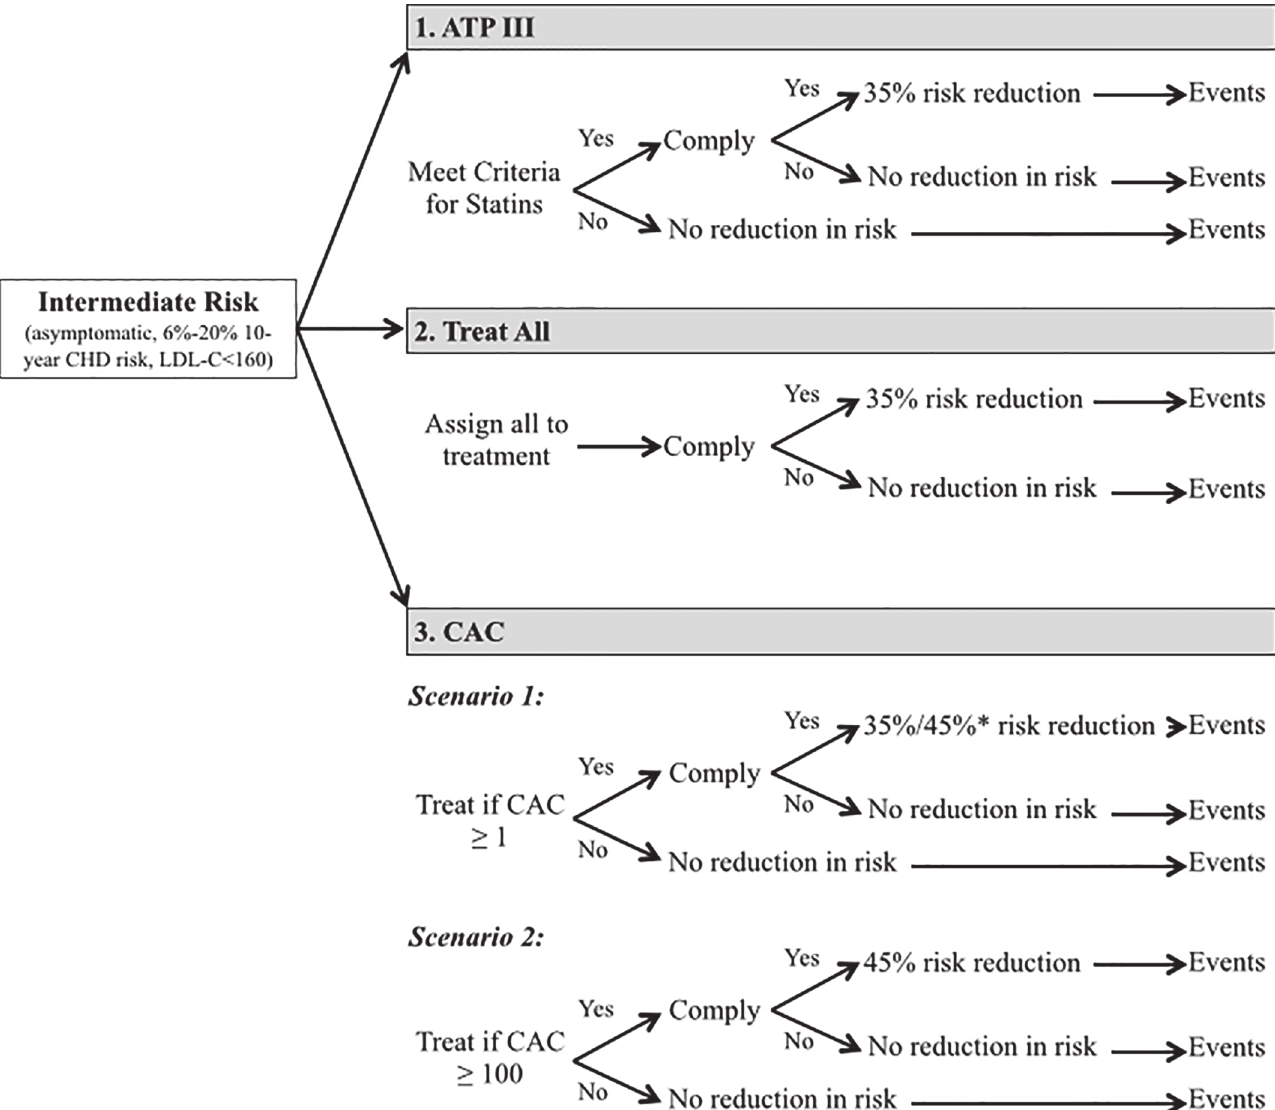
Fig 1. Schematic of the risk assessment and treatment strategies compared. * Patients with 1 (cid:3) CAC < 100 are advised to initiate standard statin therapy, which is assumed to provide a mean 35% reduction in the relative risk of CVD events. Patients with CAC (cid:1) 100 are advised to begin intensive therapy, which provides a mean 45% reduction in the relative risk of CVD